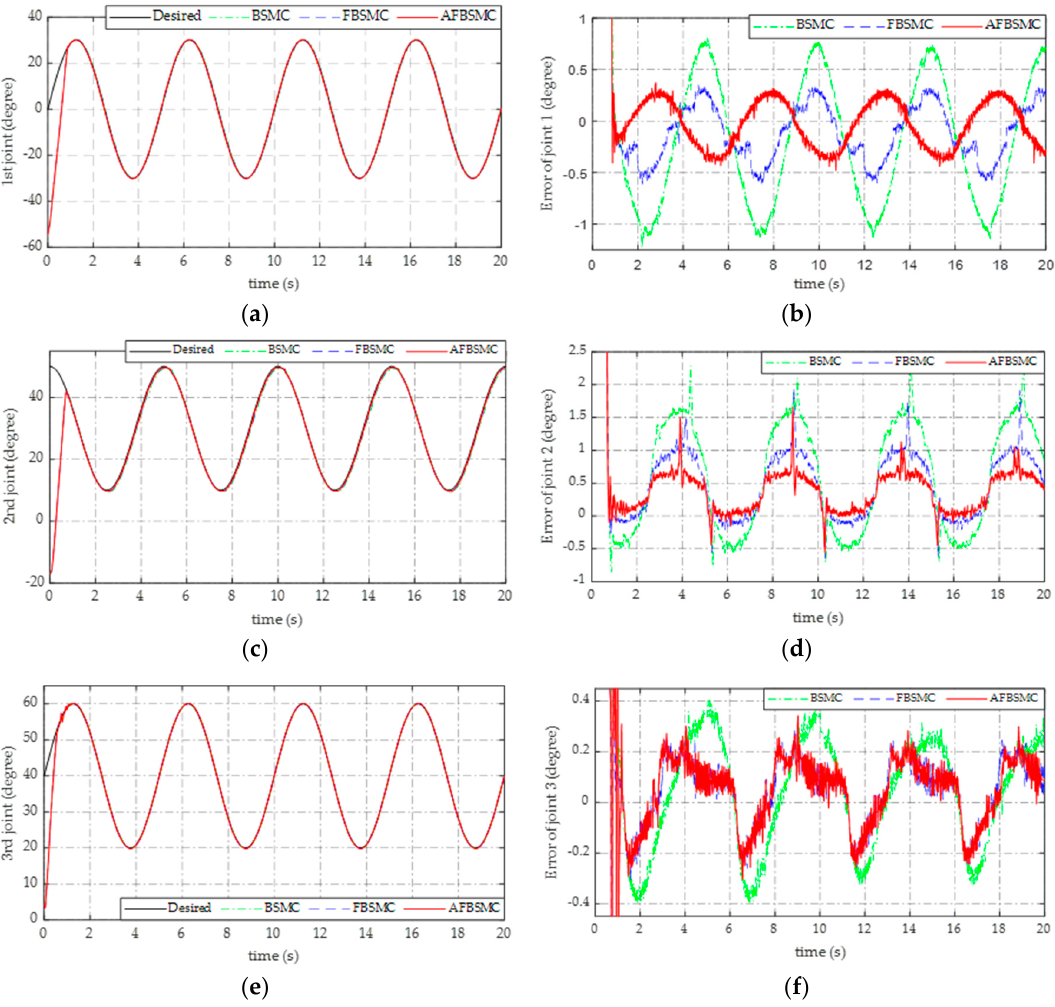
Figure 23. The tracking performance of the three joints in case of sinusoidal signal with load: ( a ) The first joint and ( b ) its error; ( c ) the second joint and ( d ) its error; ( e ) the third joint and ( f ) its error in comparison between BSMC and FBSMC and AFBSMC.